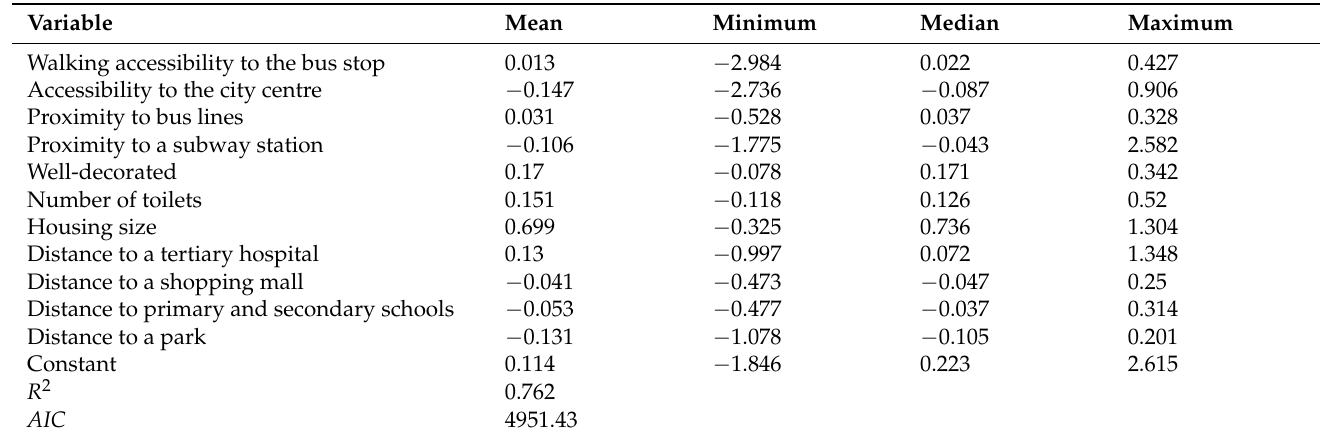
Table 3. GWR model